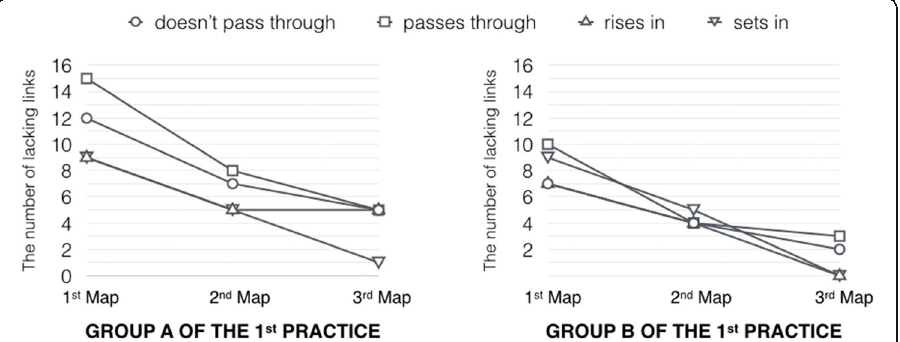
Fig. 8 The number of lacking links of each group of the first